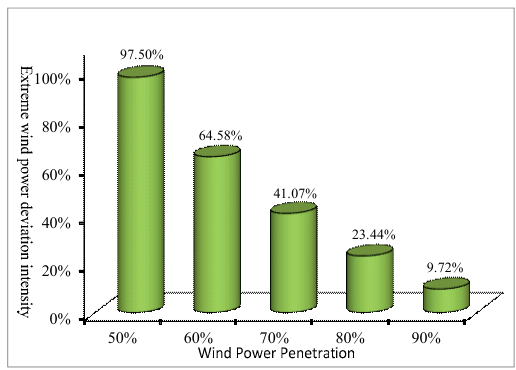
Figure 5. Extreme wind power deviation intensity under different degrees of wind power penetration.